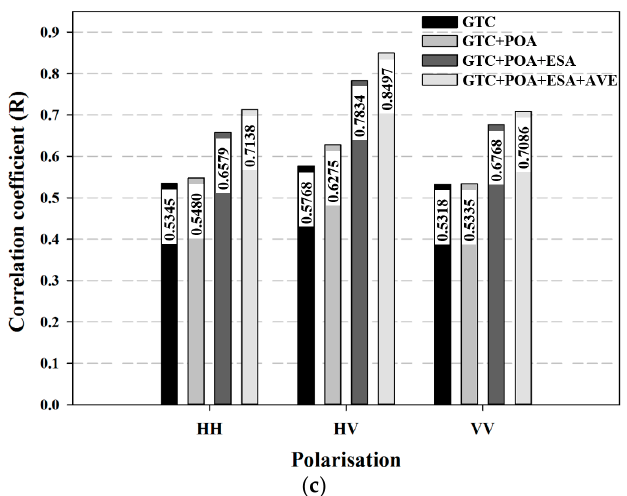
Figure 23. The validation results based on SRTM DEM (30 m): ( a ) Correlation between ψ of ASTER DEM and ψ of SRTM DEM; ( b ) Correlation between θ loc of ASTER DEM and θ loc of SRTM DEM; ( c ) The correlation coefficient between backscattering coefficients of different correction steps and forest AGB.